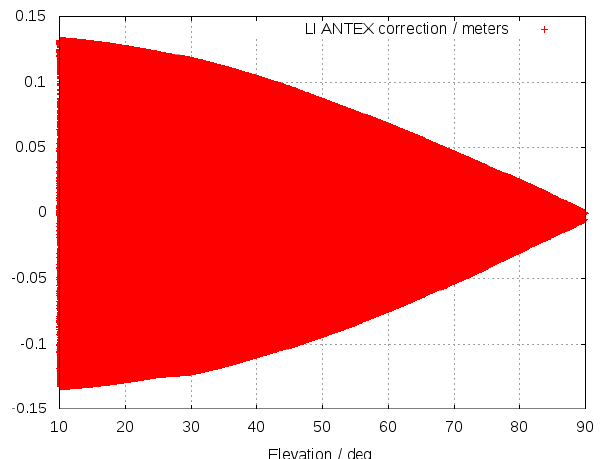
Figure 5. GPS receiving antenna corrections for the MetOp LEOs in ionospheric combination during day 176 of year 2020.